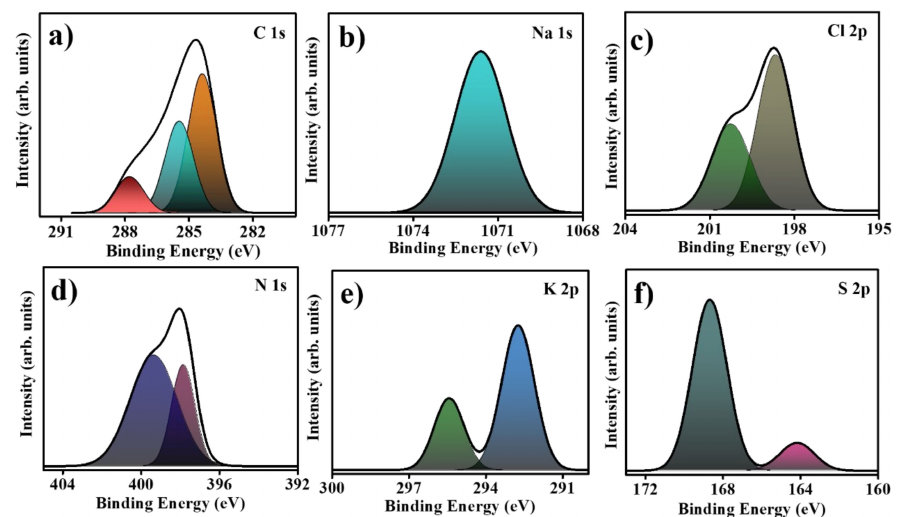
Figure 3. Deconvoluted XPS spectra of ( a ) C1s, ( b ) Na1s, ( c ) Cl2p, ( d ) N1s, ( e ) K2p, and ( f ) S2p for HUC.